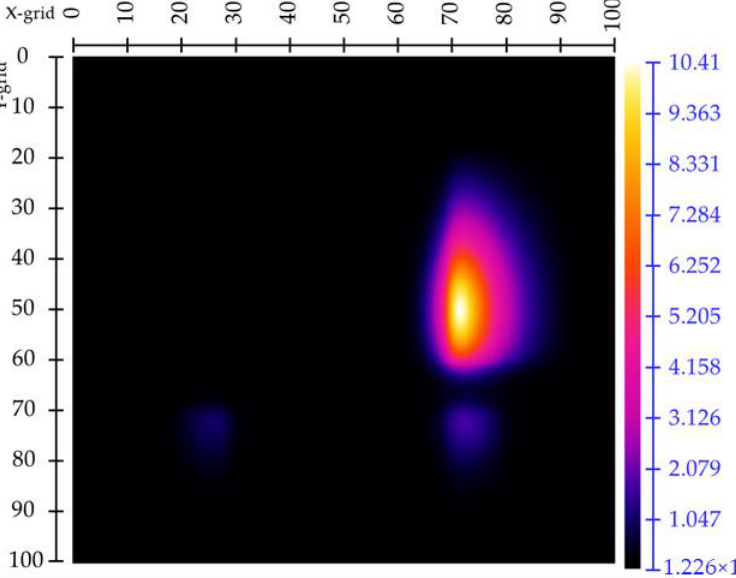
Figure 7. The temperature distribution after 3 s from the start of vibration generation (location of the center of the vibration transducer x = 50, y = 50).